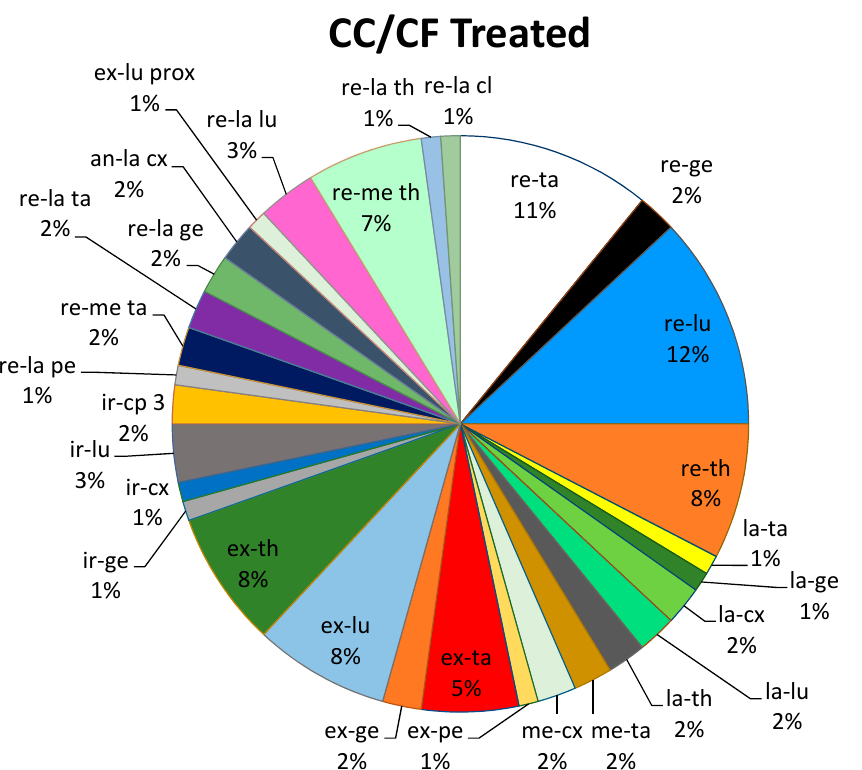
Figure 5. The treated Centers of Coordination (CC) or Centers of Fusion (CF) were all located at a distance of at least 20 cm from the area (PIIS) where algometer measurements were taken. 26% of the points were located in the lumbar region (lu), 26% in the thoracic region (th), 25% in the lower leg (ta), 7% in the thigh (cx), 10% at the level of the knee (ge) and 3% in the foot (pe) and only 3% were in the cervical and head regions (cl, cp).